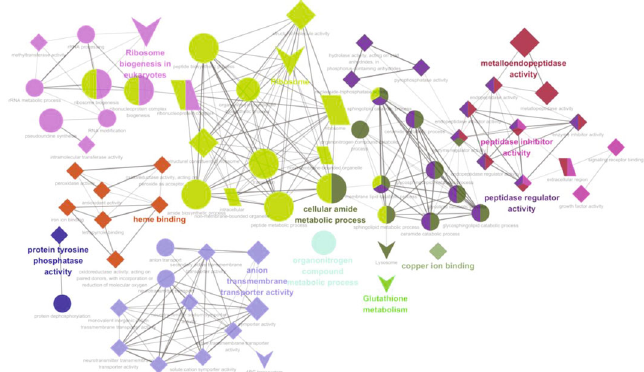
Figure 2: Network of enriched GO terms and KEGG pathways. The circle represents BP, the diamond represents MF, the quadrilateral represents CC, and the arrow represents the pathway. Based on the kappa score level ( ≥ 0.1), the term is used as a functional grouping network of connecting nodes. For each group, the size of the nodes indicates their importance, and the largest node size represents the most critical path.